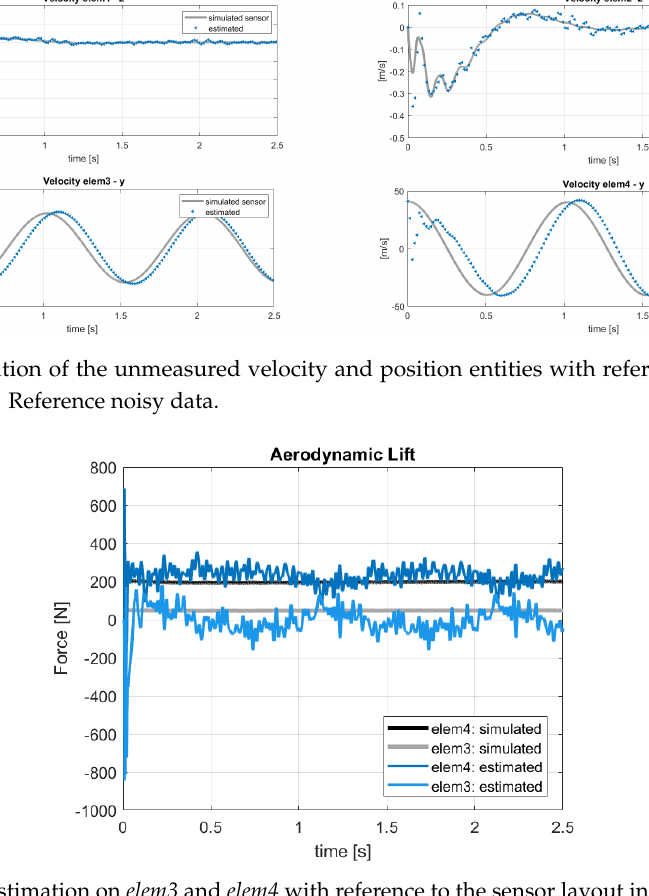
Figure 9. Force estimation on elem3 and elem4 with reference to the sensor layout in Table 2. Reference noisy